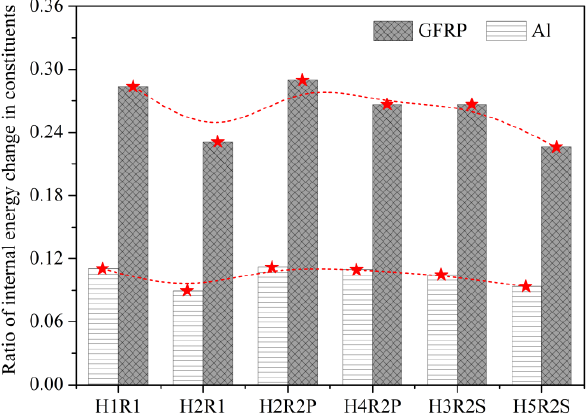
Figure 13. Ratios of internal energy change in constituents of Glare induced by off-axis load.